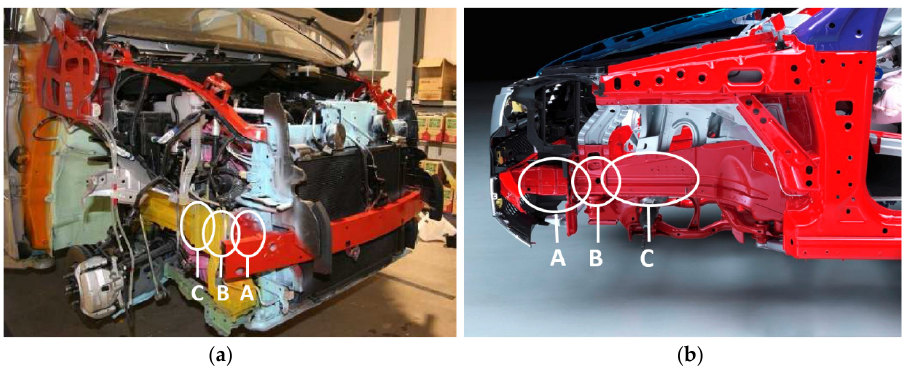
Figure 1. The structure of a passenger van ( a ) and a passenger car ( b ).